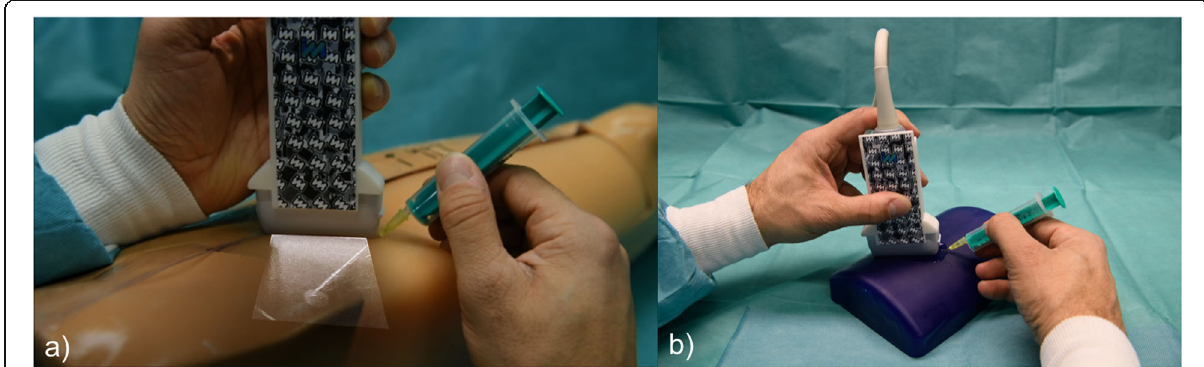
Fig. 3 Demonstration of the study setup, using augmented reality in situ ultrasound to puncture the soft tissue lesions in the leg phantom with operator view ( a ) or the vessel in the blue phantom without operator view ( b )